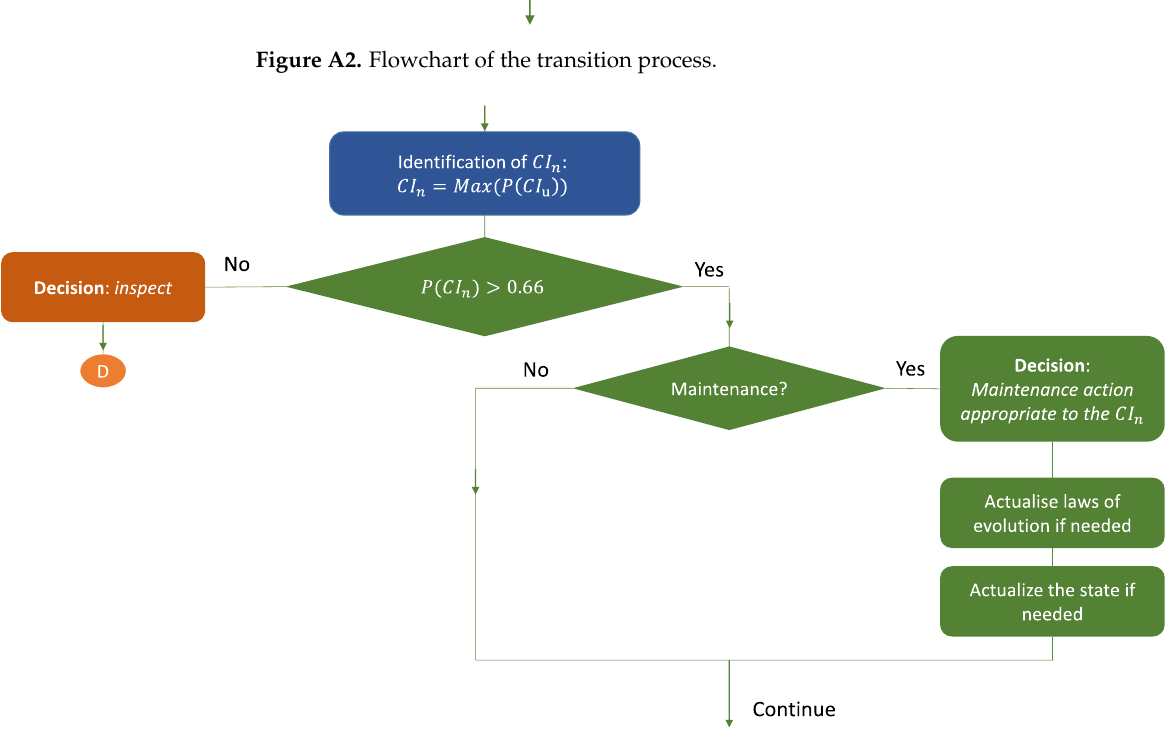
Figure A2. Flowchart of the transition process.